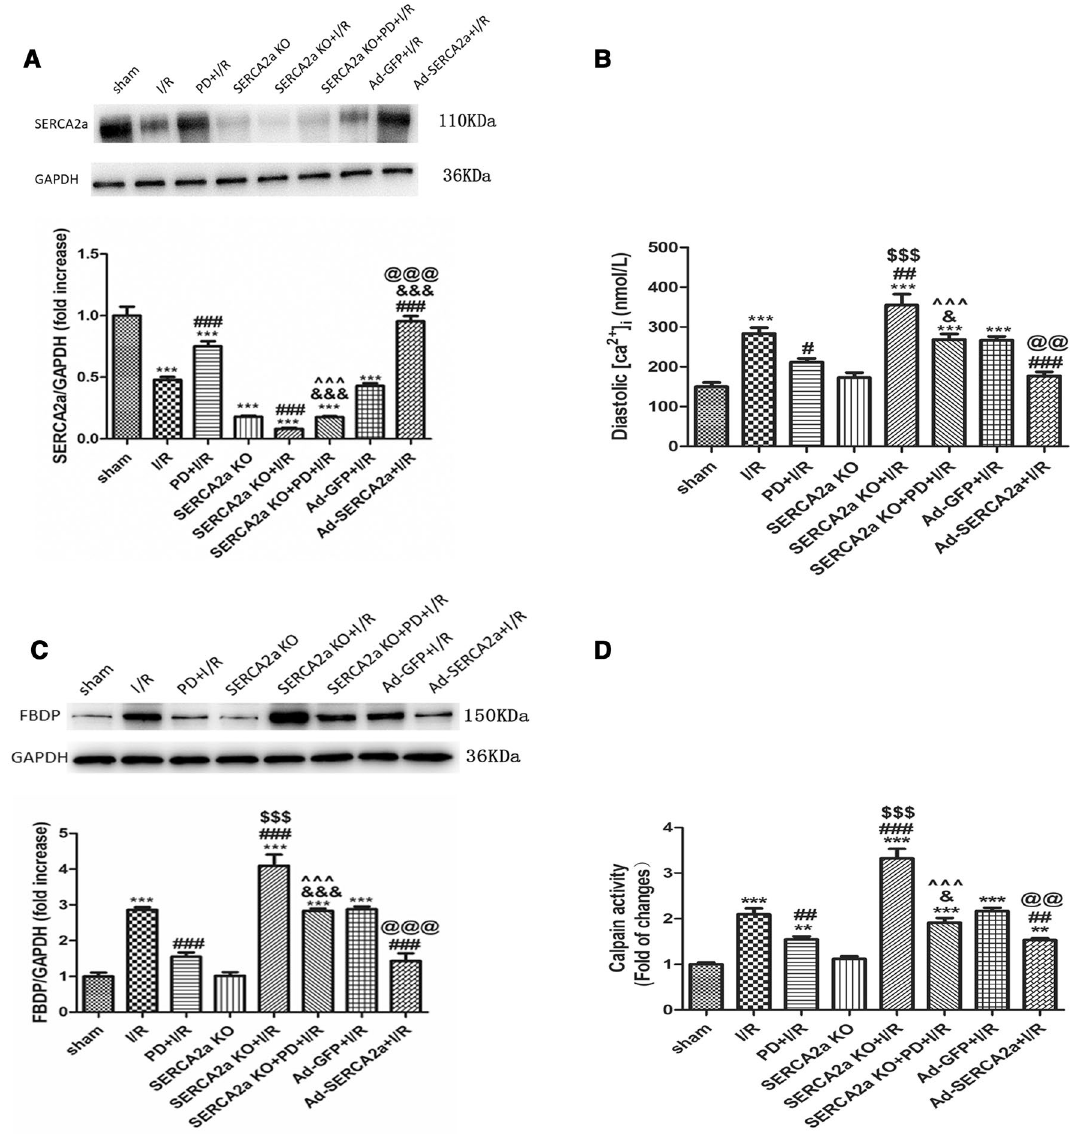
Figure 2. SERCA2a regulated calpain activity via [ca 2+ ] i in myocardial I/R mice. ( A ) The level of SERCA2a protein expression in each group. GAPDH was used as the internal control. The grouping of gels/blots cropped from different parts of the same gel. Uncropped blots are available in Supplementary Fig. 2A. ( B ) The diastolic [ca 2+ ] i of cardiomyocyte in each group. ( C , D ) The calpain activity in each group. GAPDH was used as the internal control. The grouping of gels/blots cropped from different parts of the same gel. Uncropped blots are available in Supplementary Fig. 2C. Individual data points are presented in Supplemental Fig. 2A-D. ** P < 0.01, *** P < 0.001 versus sham; # P < 0.05, ## P < 0.01, ### P < 0.001 versus I/R; & P < 0.05, &&& P < 0.001 versus PD + I/R; $$$ P < 0.001 versus SERCA2a KO; ^^^ P < 0.001 versus SERCA2a KO + I/R; @@ P < 0.01, @@@ P < 0.001 versus Ad-GFP + I/R. n = 3; mean ±